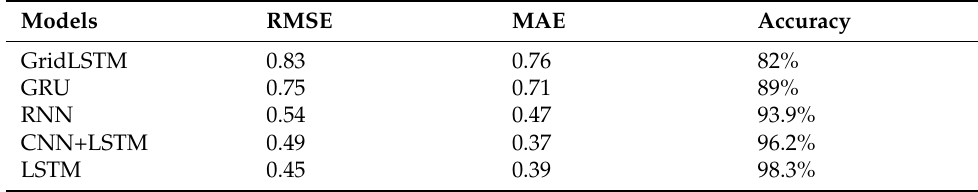
Table 7. Performance evaluation of different prediction